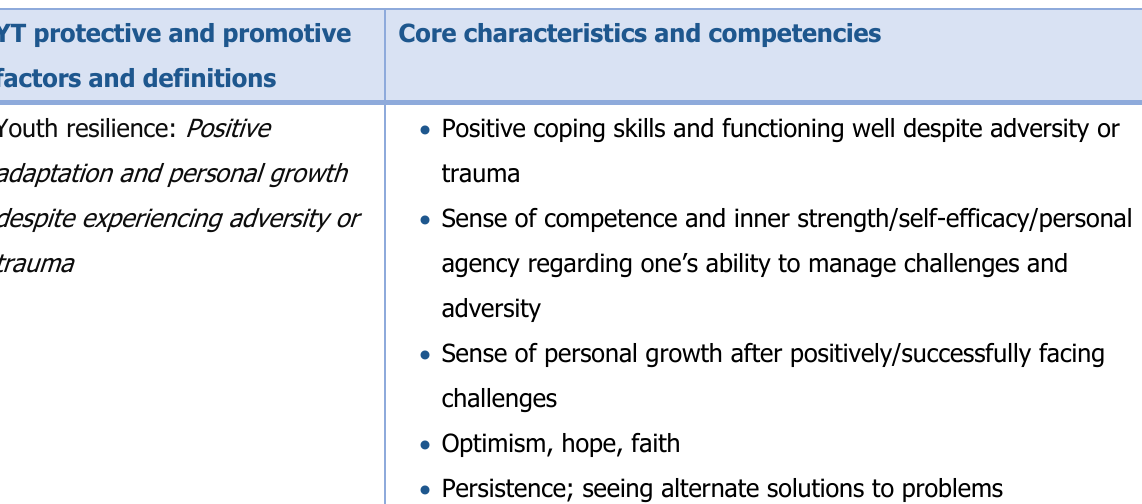
Table 1. Core Characteristics and Definitions of the YT Protective and Promotive